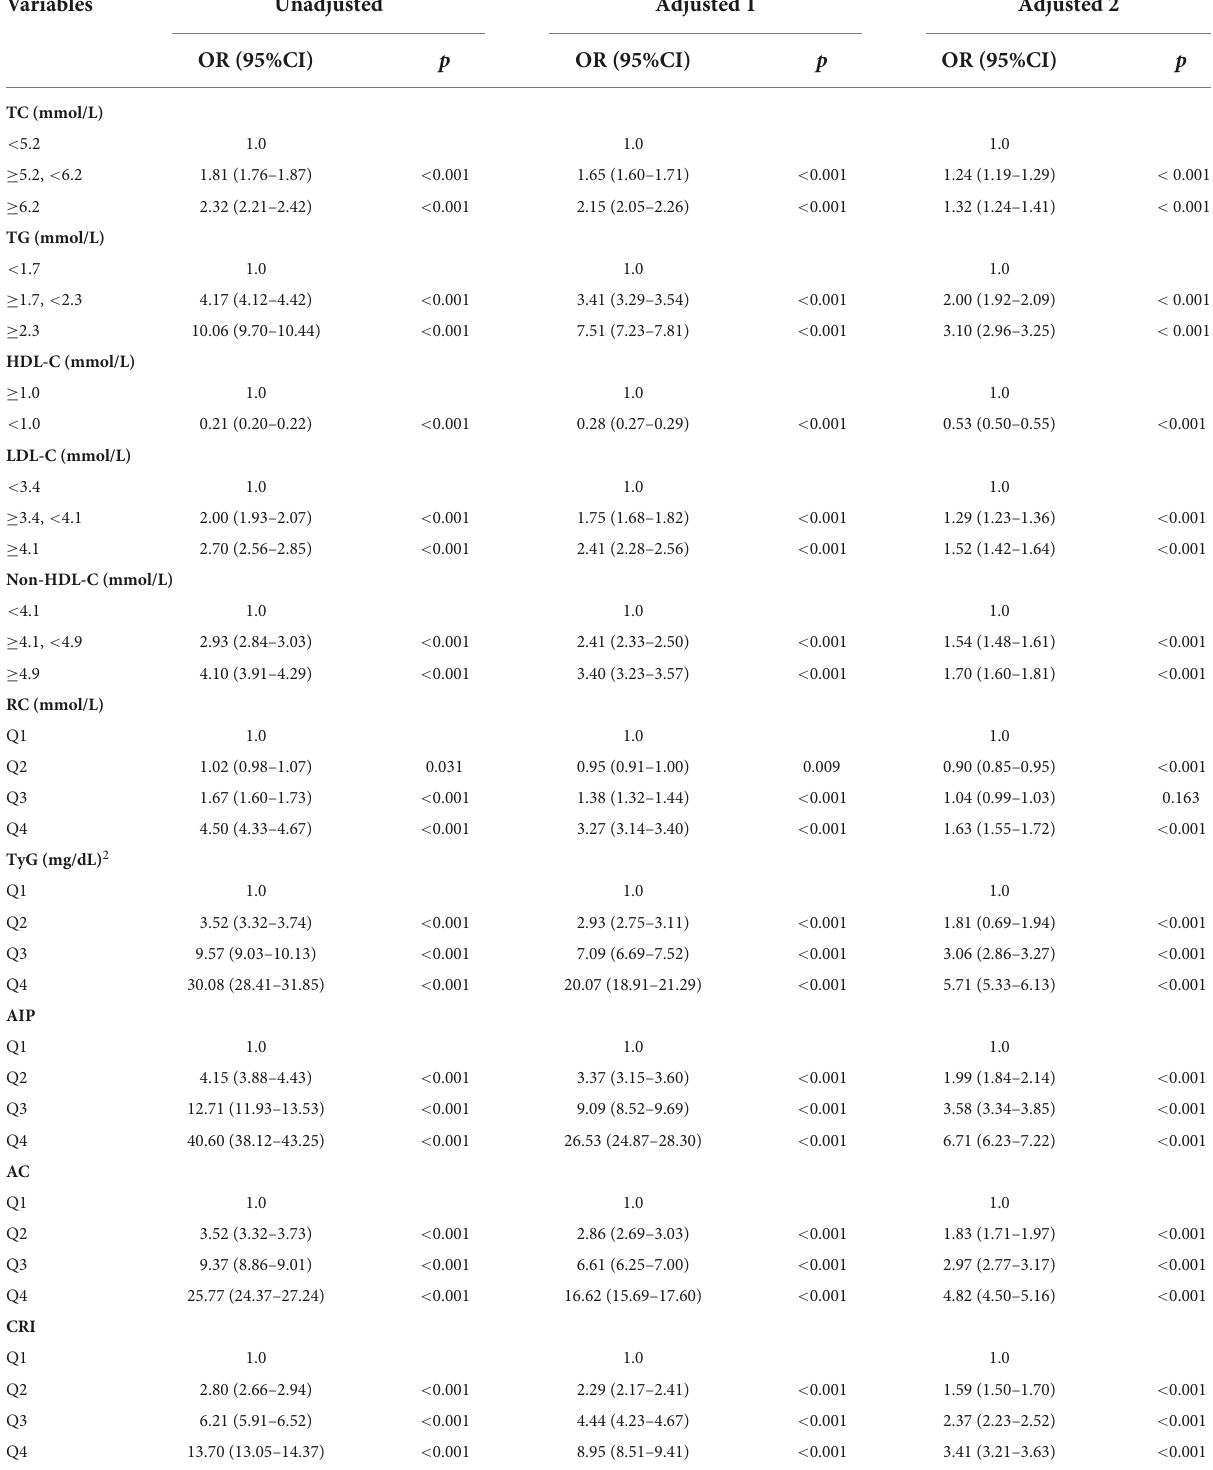
TABLE 2 Logistic regression analysis of lipid parameters with NAFLD ( n =